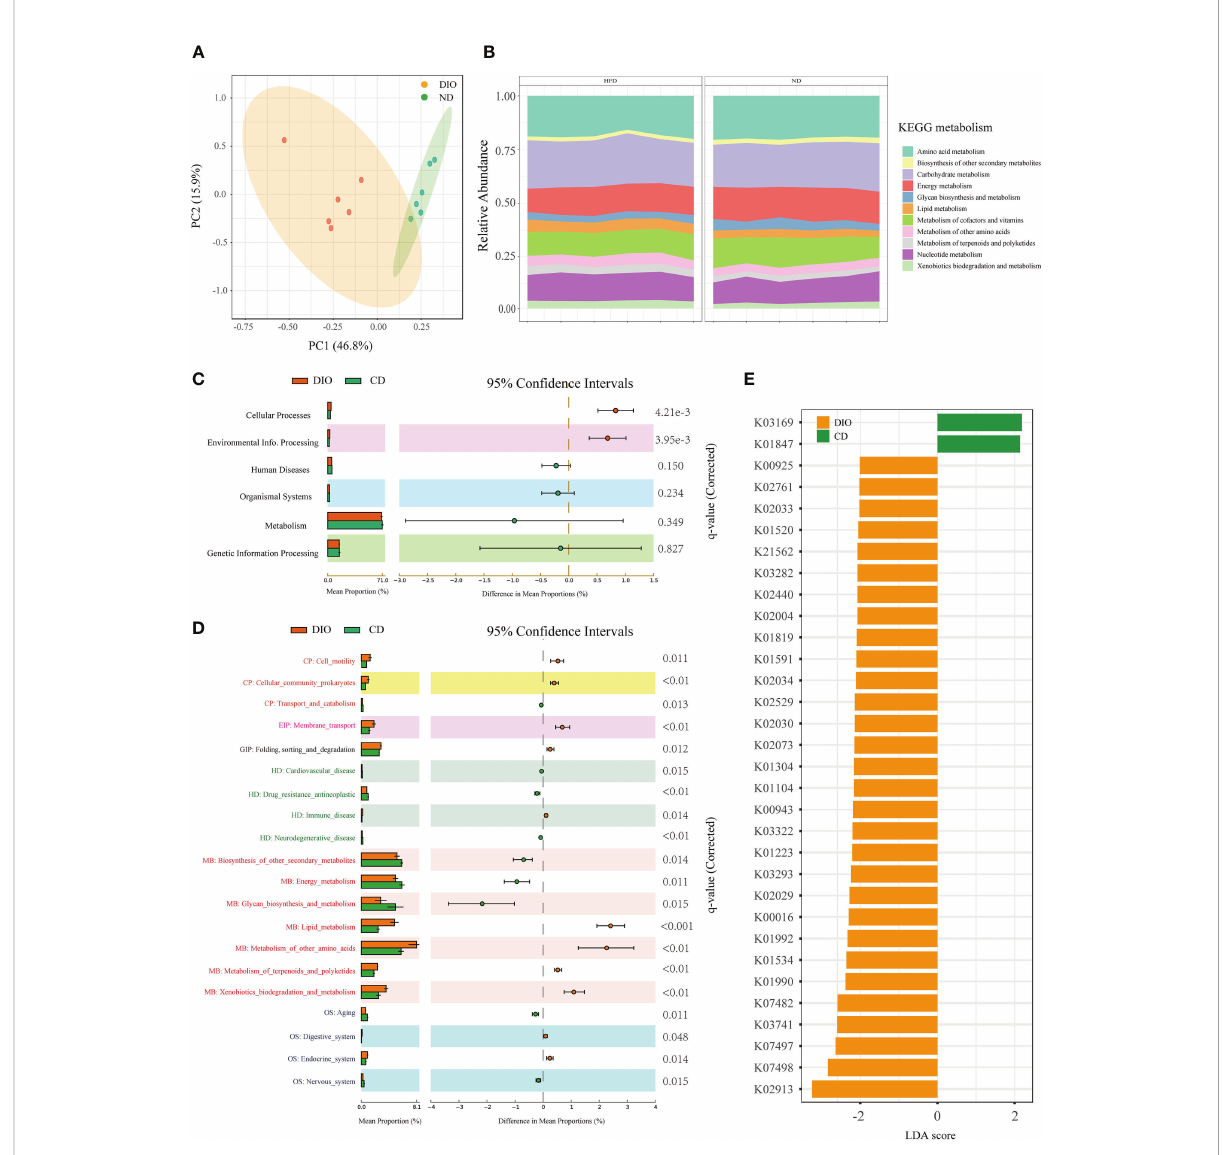
FIGURE 5 Microbial gene function annotation by KEGG in MHO and controls. (A) PCoA based on KEGG modules revealed differences in microbial functions between DIO and controls. (B) The composition of KEGG modules in both MHO and controls. The KEGG pathways of level 1 (C) , level 2 (D) , and KO (E) were all disrupted in the MHO groups, the relative to healthy controls, as identi fi ed by STAMP